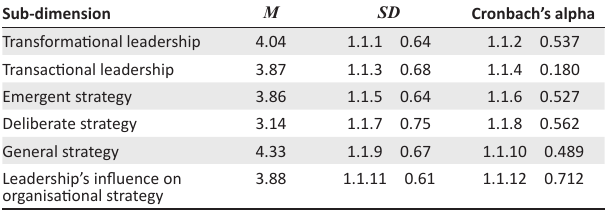
TABLE 1: Descriptive statistics for composite scores used to test hypotheses 1 to 3 ( n = 197).